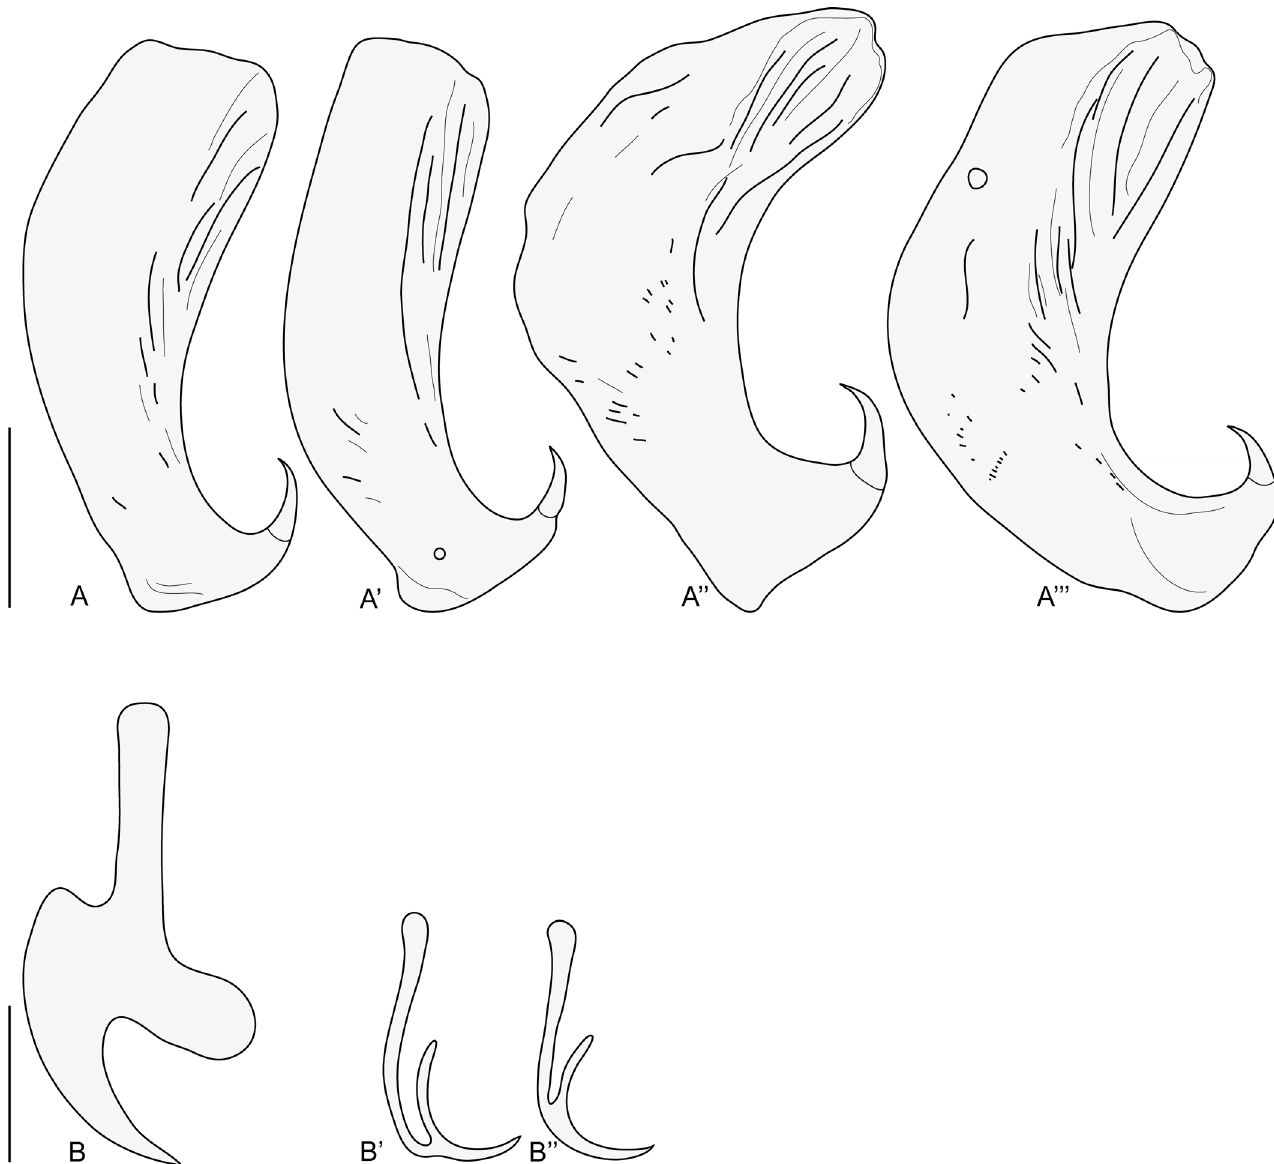
Figure 8. Indopolystoma parvum n. gen. n. sp. from Zhangixalus omeimontis . Hamuli and marginal hooklets from holotype and